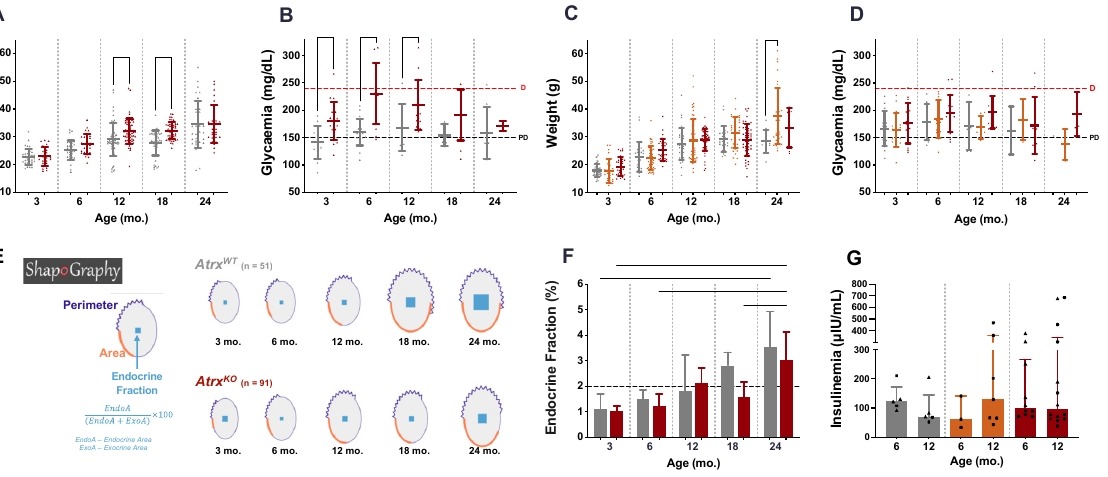
Figure 4. Endocrine fitness: weight, glycaemia, endocrine fraction, and insulinaemia. Weight and glycaemia analyses indicate that Atrx KO male ( A , B ) and female ( C , D ) mice concurrently present increased weight gains and glycaemia levels than age- and sex-matched controls. Age groups of 9, 15, and 21 mo. were included in 12, 18, and 24 mo. age groups, respectively ( A – D ). Atrx KO mice ( E , F ); other morphological parameters like perimeter and area also increase less with ageing ( E ); 6 h fasted insulin levels do not significantly differ among groups ( G ). Results are shown as mean ± SD ( A – D ) or median ± IQR ( F , G ); triangles and circles are used to represent values of male and female mice, respectively ( G ). Grey means Atrx WT , red means Atrx HOM ( A – D , G ) or Atrx KO ( E , F ), and orange means Atrx HET